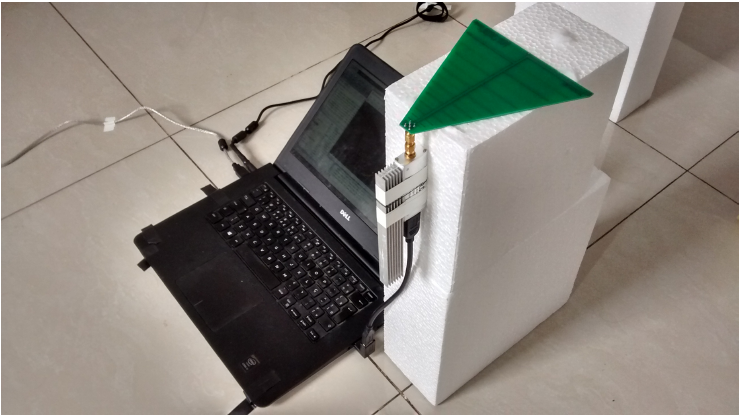
Figure 5. The Rx radio is connected to the receiving antenna and computer via a USB cable. On the left of the computer, we see a second USB cable that is connected to the Tx radio (not shown in